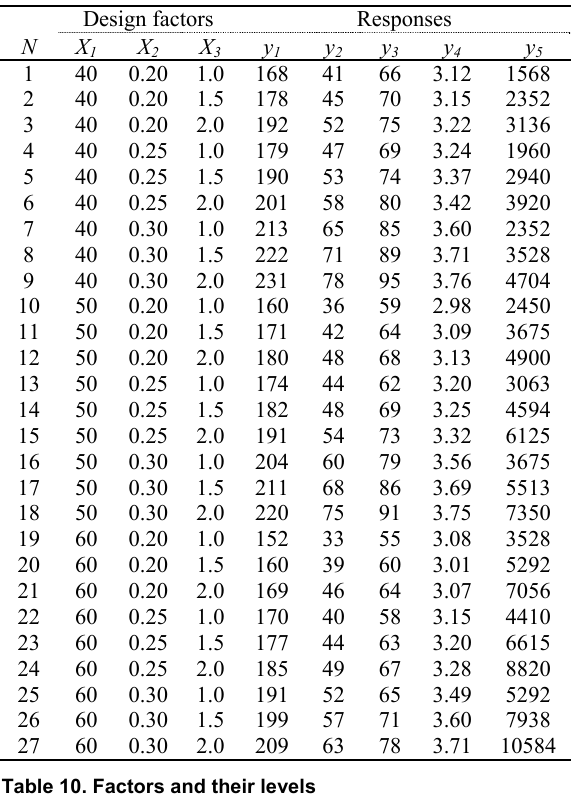
Table 9. Design matrix and experimental results Design factors N